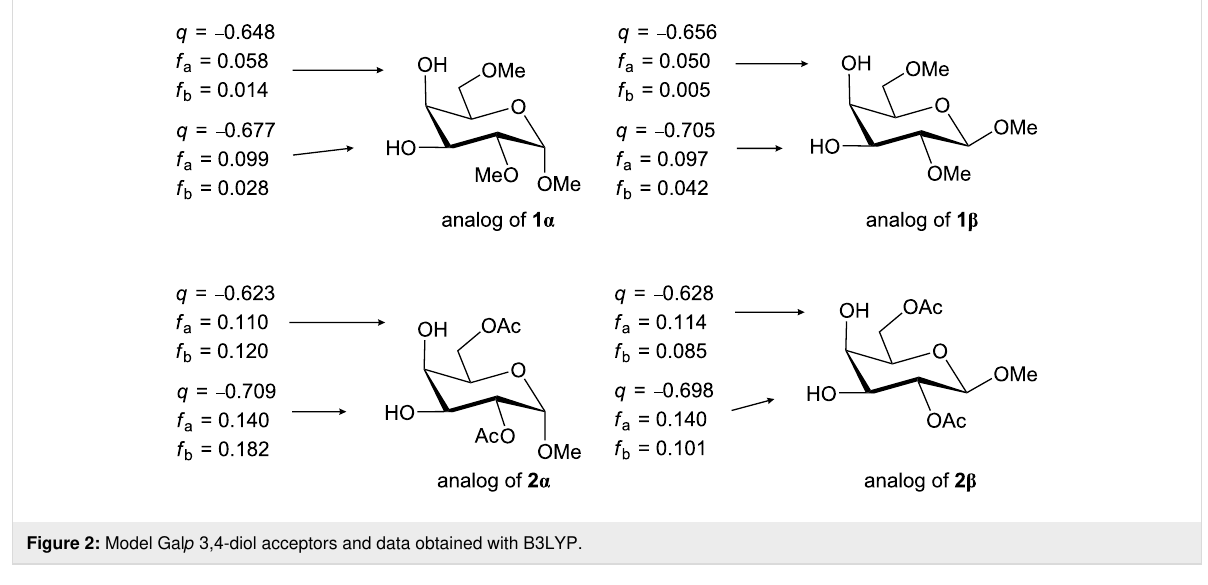
Figure 2: Model Gal p 3,4-diol acceptors and data obtained with B3LYP.